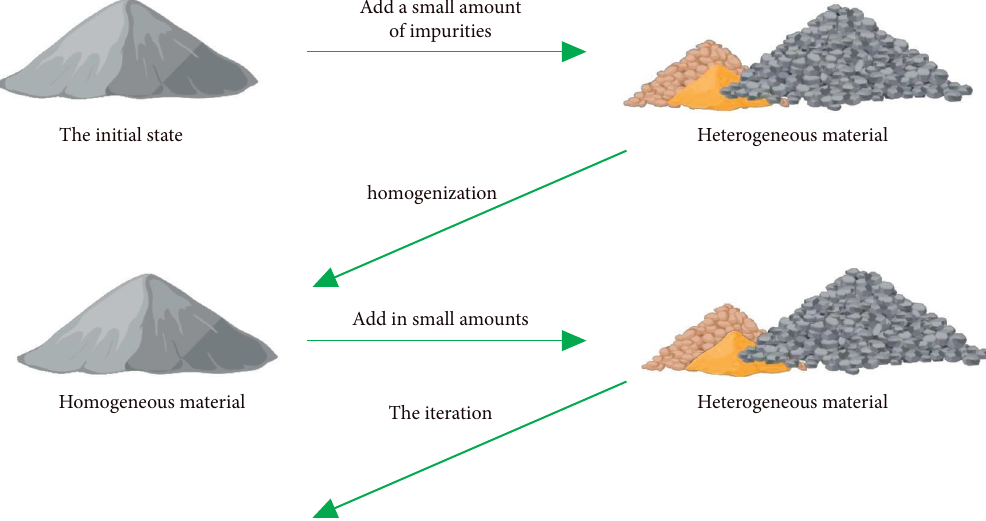
Figure 1: Differential equivalence